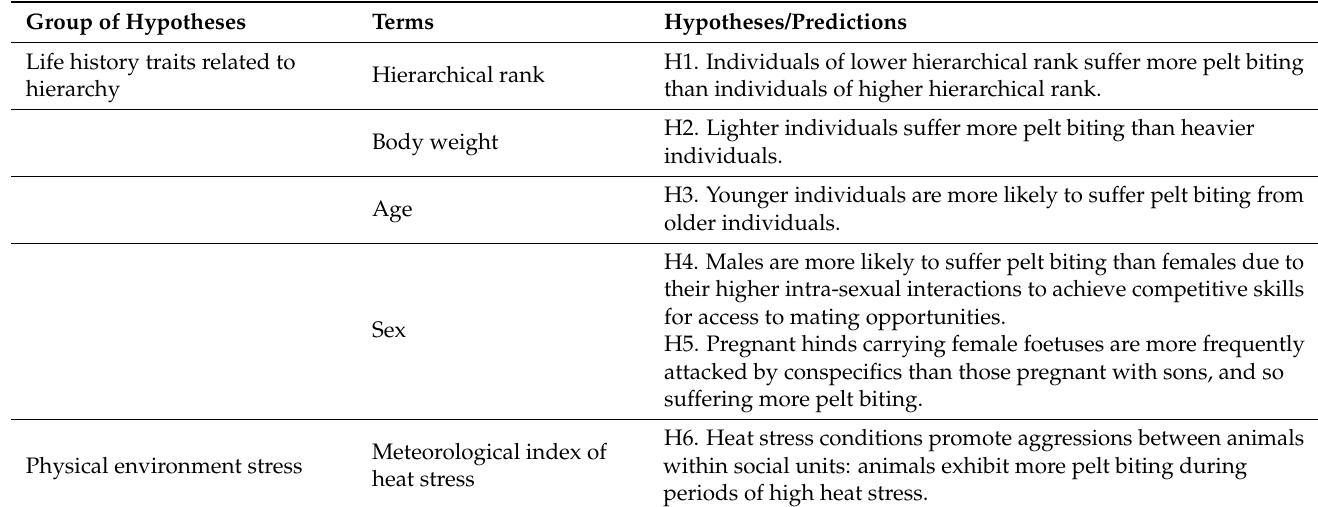
Table 1. Hypotheses and predictions on factors affecting pelt biting. Hypotheses are not mutually exclusive. Group of Hypotheses Life history traits related